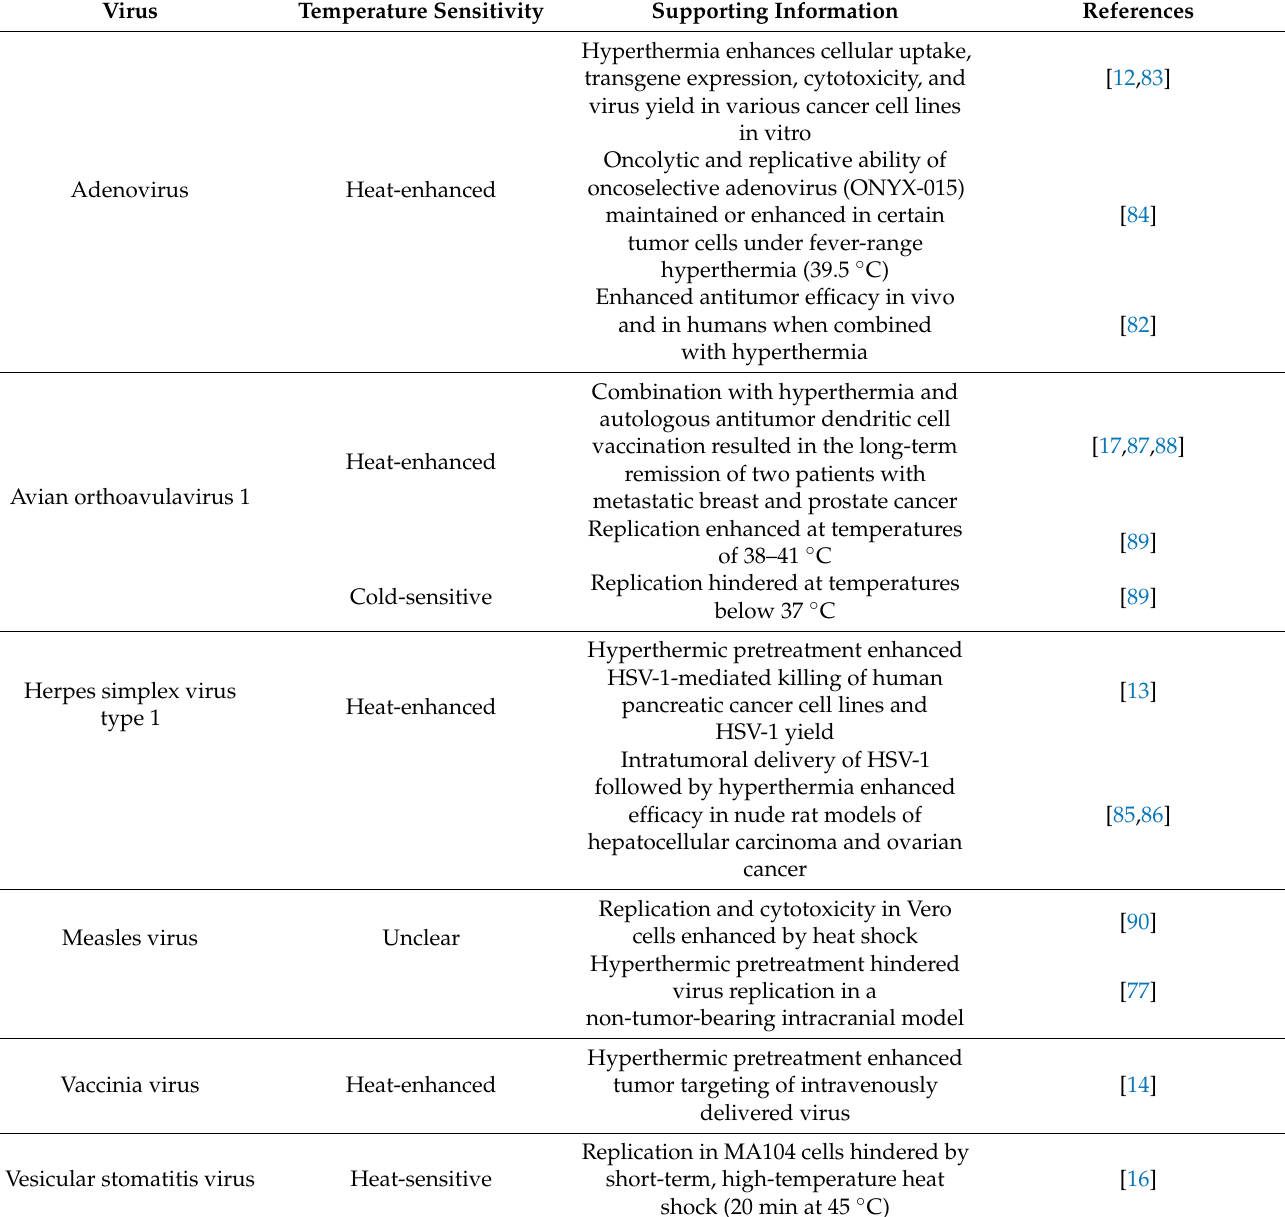
Table 2. Temperature sensitivity of various oncolytic virus